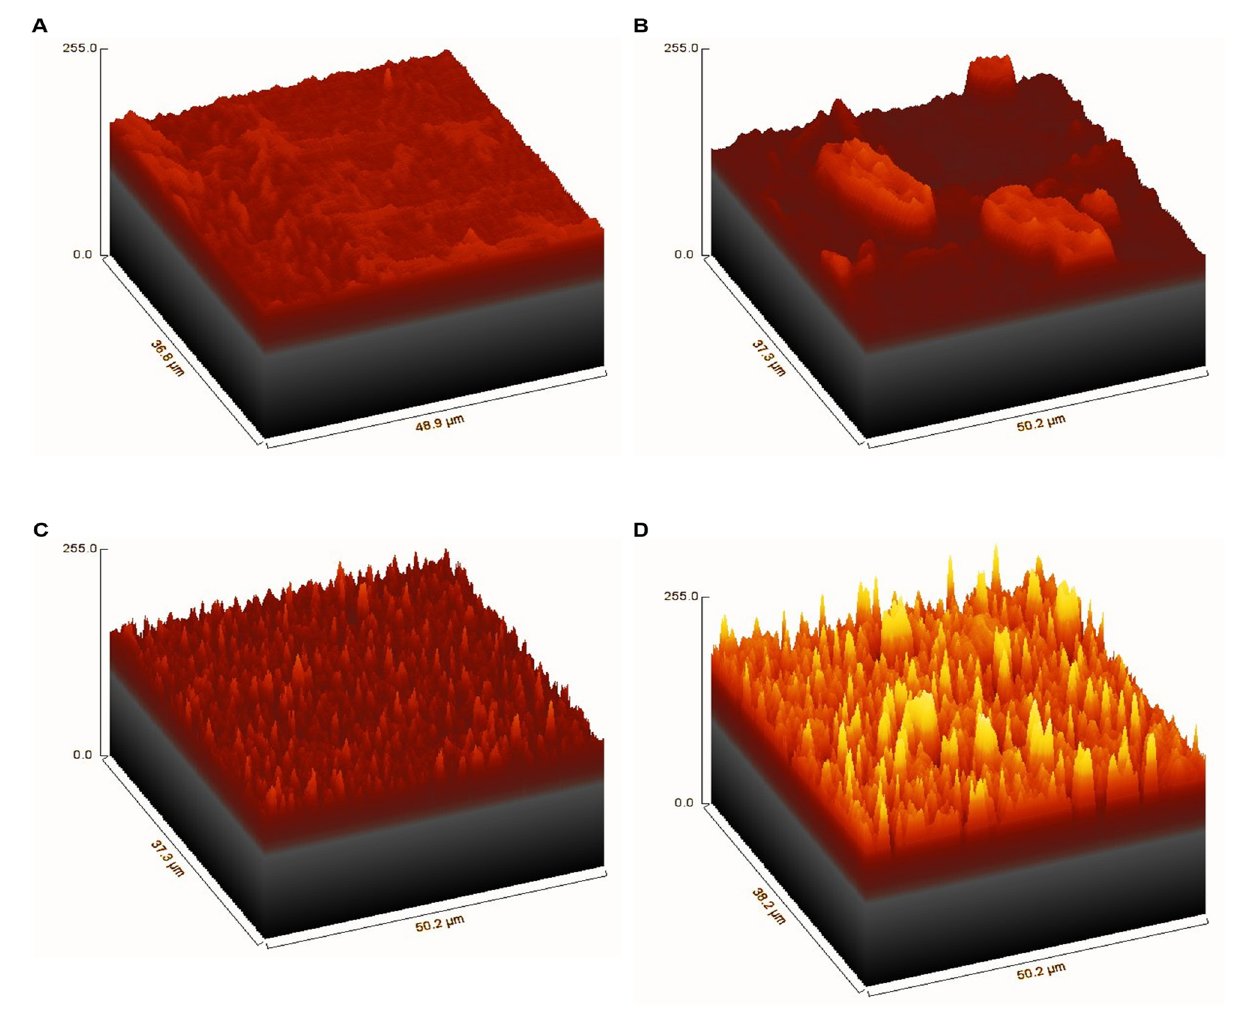
Figure 5. Three-dimensional representation of SEM images of ( A ) the non-coated PLA film, ( B ) the graphene-coated film, graphene-coated film, ( C ) the TiO 2 -coated film, and ( D ) the graphene/TiO 2 -coated ( C ) the TiO 2 -coated film, and ( D ) the graphene/TiO 2 -coated film.